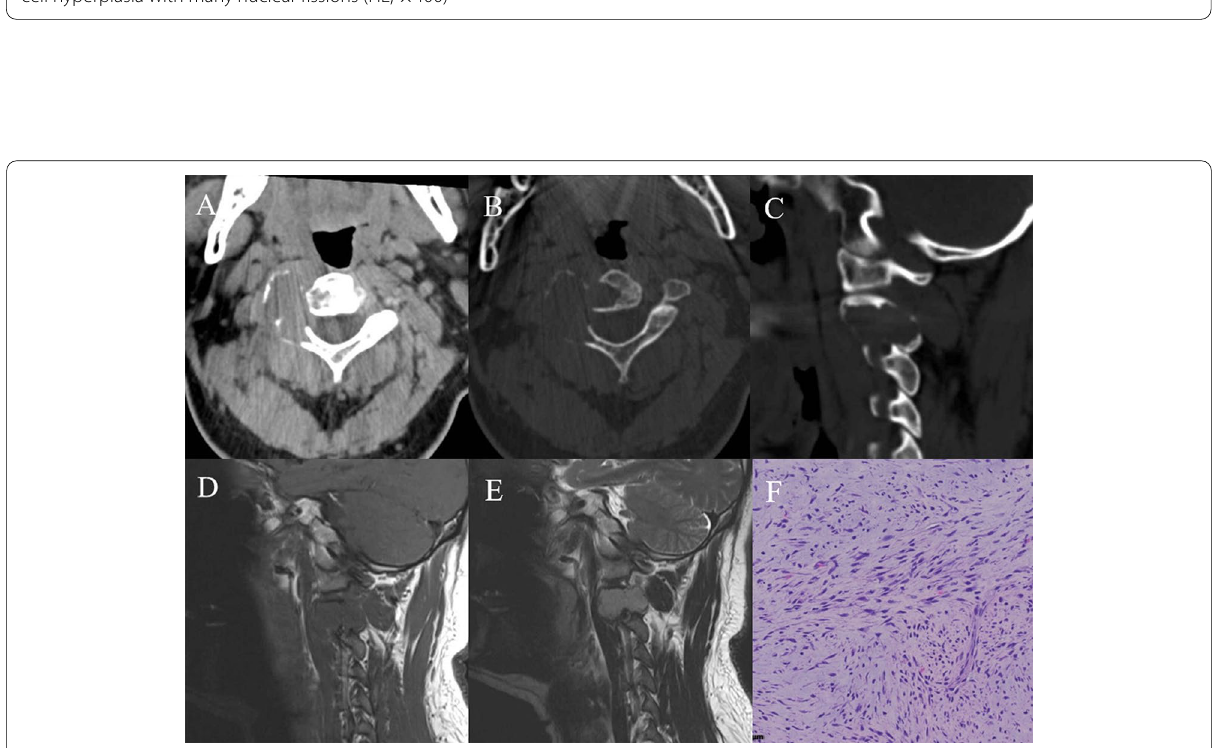
Fig. 3 A 37-year-old male with C2 primary leiomyosarcoma. A Axial computed tomography (CT) showed an ill-defined isodense mass in the vertebral body and posterior elements of C2; B Axial CT bone window showed expansive bone destruction; C Sagittal CT bone window showed bone destruction in the vertebral body and posterior elements of C2; D T1 weighted imaging (T1WI) in sagittal view showed an isointense mass; E T2 weighted imaging (T2WI) in sagittal view showed an isointense mass; F The spindle cell in the tumor differentiated into densely packed smooth muscle cells; no tumor necrosis was observed (HE, ×